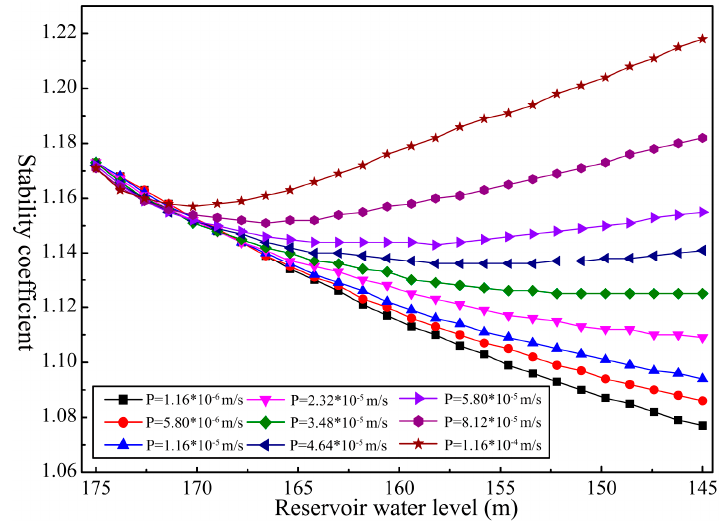
Figure 10. Comparison of stability coefficients for a drawdown rate of 0.6 m/d and different permeability coefficients .